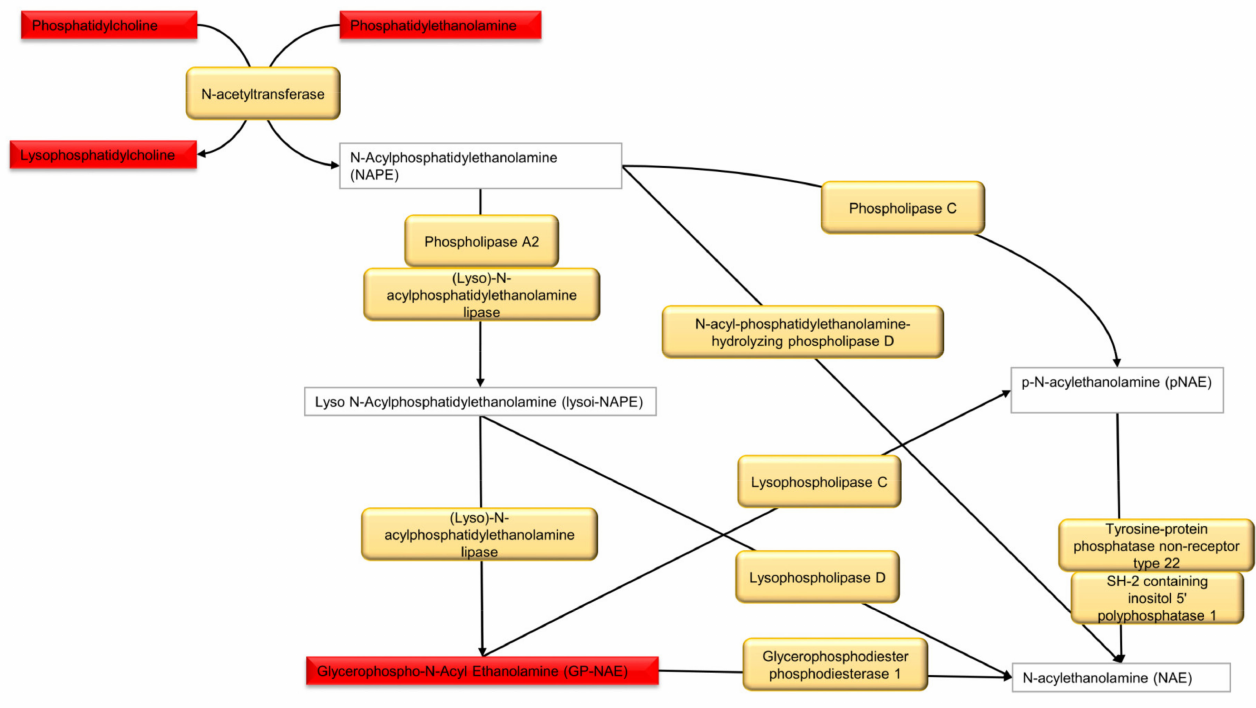
Figure 5. Pathway of endocannabinoid